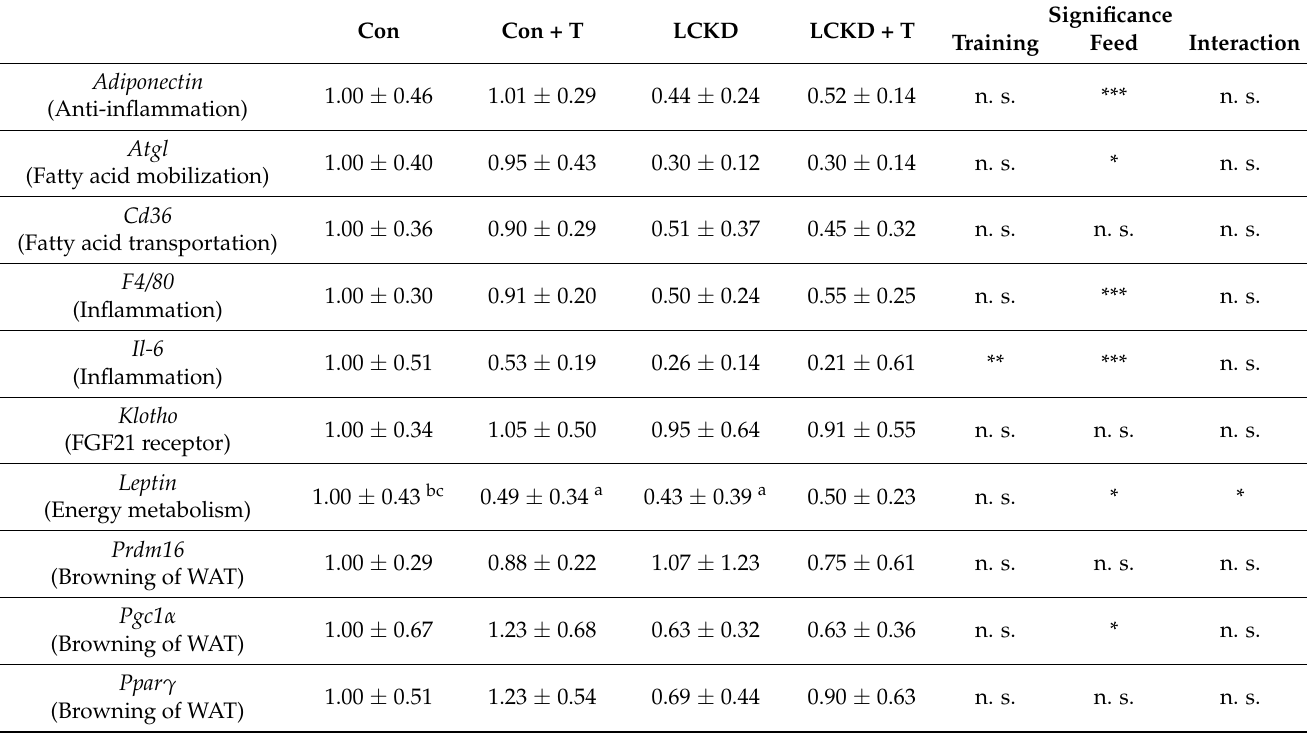
Table 7. The effect of LCKD feeding and/or training on WAT gene